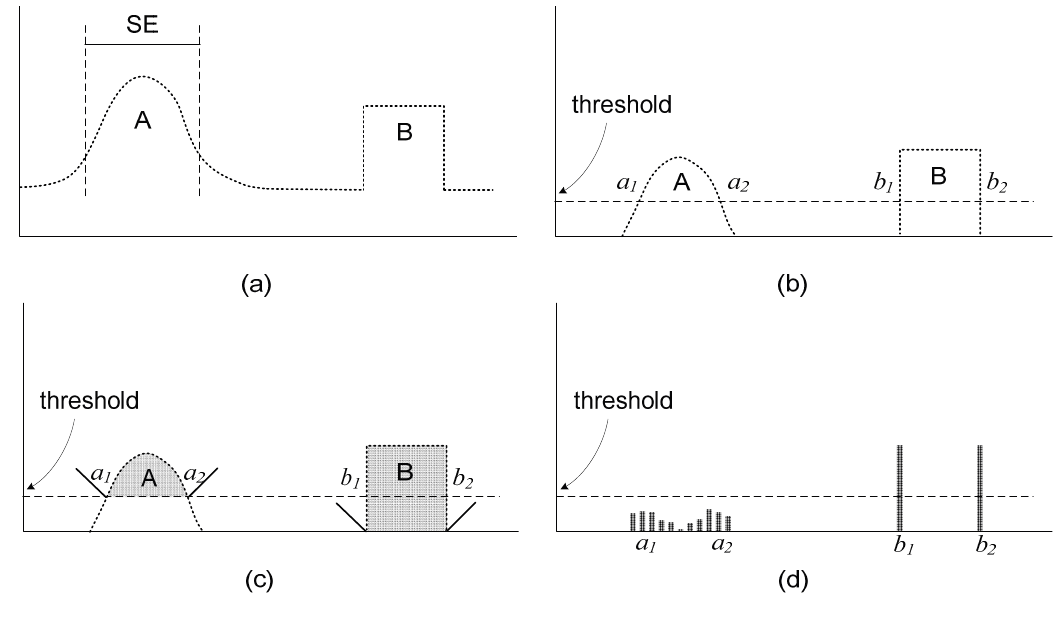
Figure 3. Example of the improved top-hat filter with brim for distinguishing protruding terrain features with dramatic elevation changes: ( a ) original point set; ( b ) top-hat transformation results; ( c ) suspicious hats inspected using surrounding brim (gray portions represent the parts extracted by thresholding top hats); ( d ) internal gradient